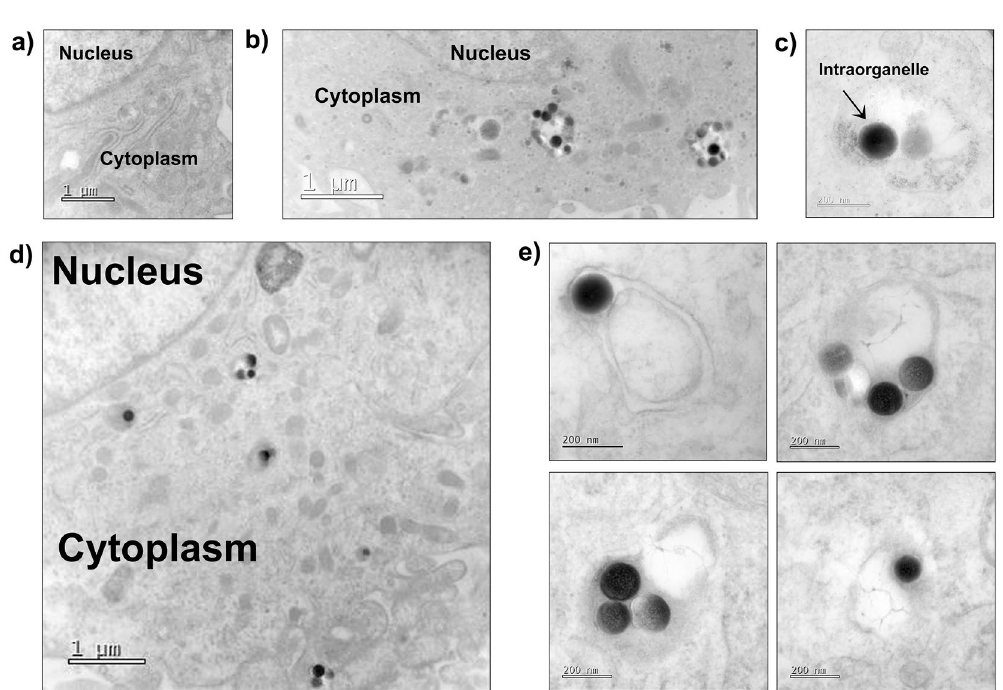
Figure 6. Permeant growth arrest allows for long term biological fate inside senescent cells. ( a ) Electron micrographs of senescent cells without SiNPs (control), ( b ) with SiNPs in the cytoplasm, and ( c ) SiNPs inside an organelle at 24 h. ( d ) Electron micrographs of a senescent cell with SiNPs in the cytoplasm, and ( e ) SiNPs intercalated into the membranes of organelles at 12